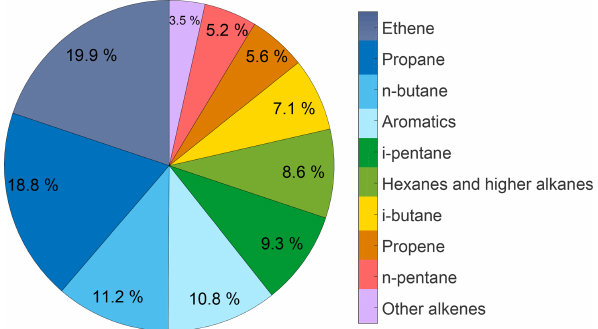
Figure 6. Composition of a typical KI ship exhaust sample. Aro- matics include benzene (2.8%), toluene (4.9%), and m -, p - xylenes (3.1%), hexanes and higher alkanes include i -hexane (2.6%), n - hexane (2.7%), n -heptane (2.2%), and octane (1.2%), and other alkanes include trans-2-butene (0.8%), 1-butene (1.5%), and 1- pentene (1.2%). The sample was measured over the Arabian Sea and background ambient mixing ratios were subtracted prior to relative composition calculation. Ethane mixing ratios were 28ppt lower inside the exhaust sample, being within the uncertainty range of the